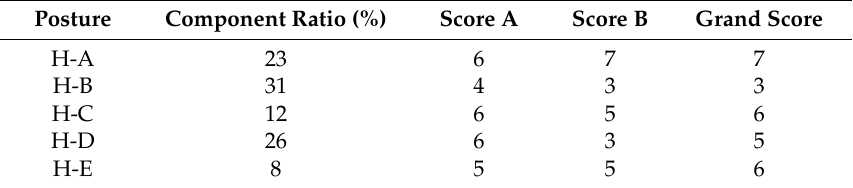
Table 3. Rapid Upper Limb Assessment (RULA) analysis